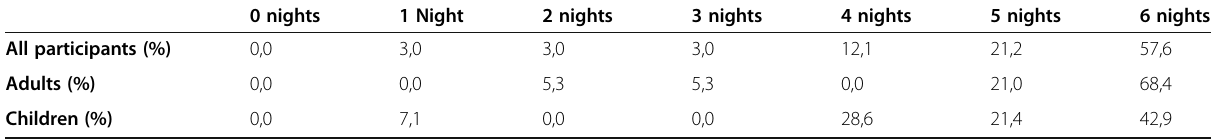
Table 2 Proportion of participants with complete sleep